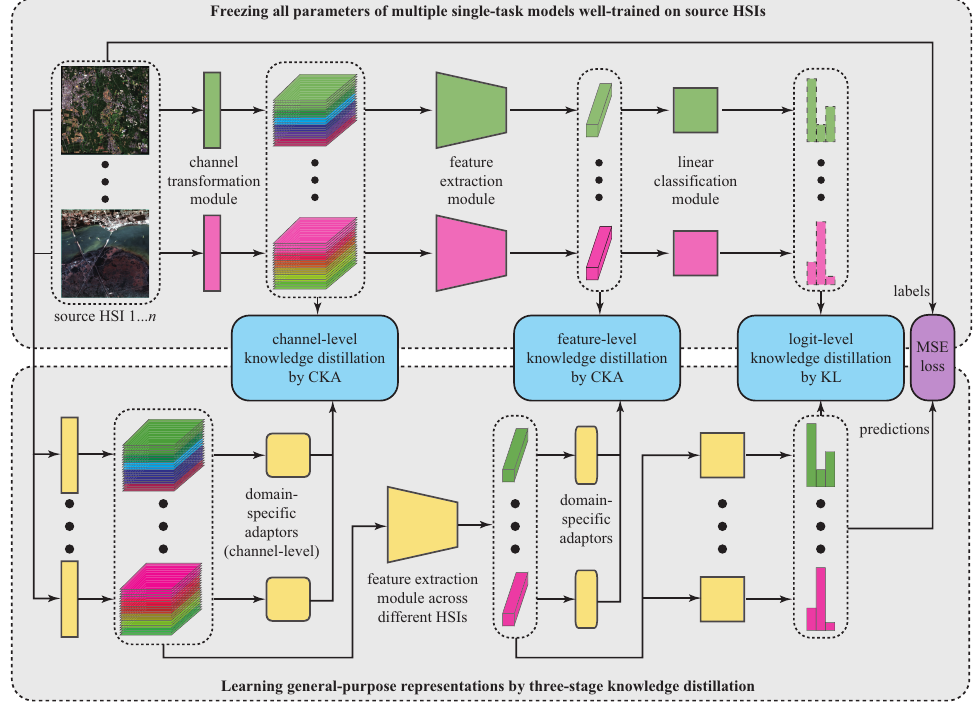
Figure 2. Schematic of the proposed general-purpose representation learning method. We first freeze all parameters of multiple single-task models well-trained on source HSIs and then attempt to make the designed multi-task model learn general-purpose representations from multiple different hyperspectral domains through the proposed three-level knowledge distillation strategy. During knowledge distillation, in addition to the three designed modules, two types of domain-specific adaptors are inserted to align the features generated by the single-task models and the multi-task model. In the channel- and feature-level knowledge distillation, a centered kernel alignment (CKA) similarity index is adopted, and in the logit-level knowledge distillation, the Kullback–Leibler (KL) divergence is adopted. For the predictions and true labels, the mean square error (MSE) function is adopted for calculating loss.